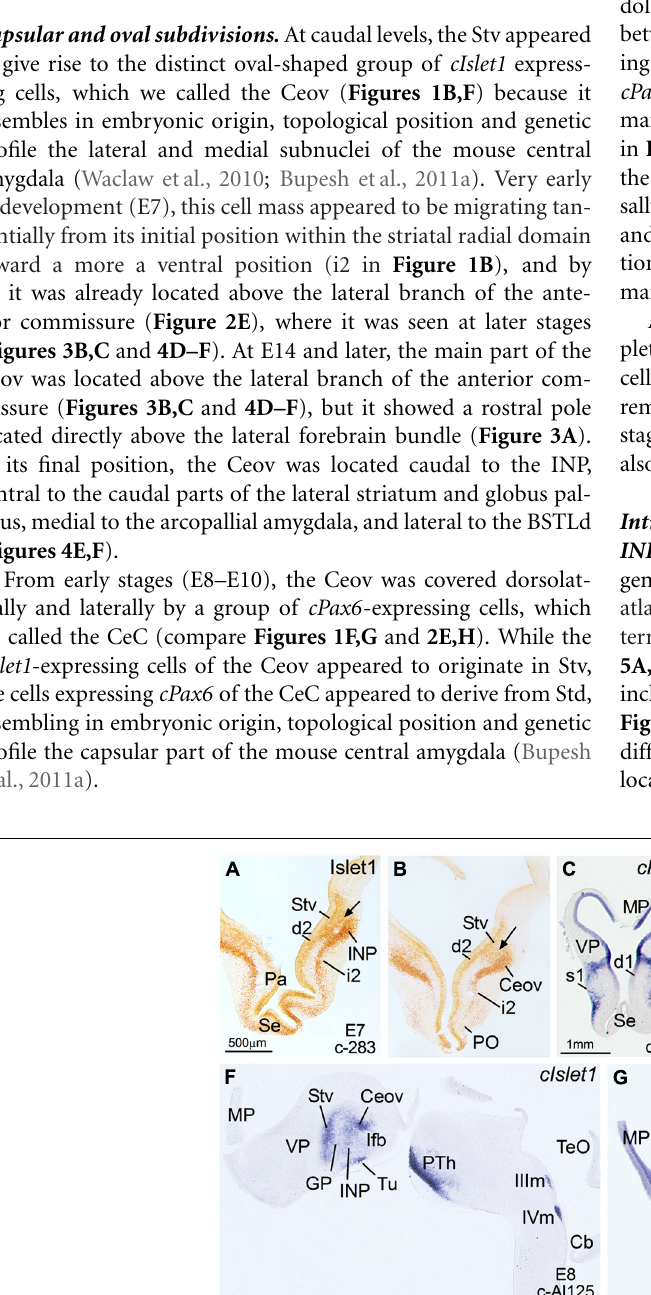
FIGURE 1 | Expression of Islet1 and Pax6 in the telencephalon of chicken embryos at E6–E8. (A–E) Low-magnification digital images of frontal telencephalic sections of the chicken embryo ( A,B : E7; C–E : E6), immunostained for Islet1 (A,B) or hybridized for cPax6 (C–E) .The arrows in (A) and (B) are showing the continuity between the subventricular zone of the ventral striatal division of the (Stv) and the mantle zone, where the primordia of several structures start to develop: intrapeduncular nucleus (INP) at intermediate telencephalic levels (A) , and Ceov at caudal levels (B) . d, i and